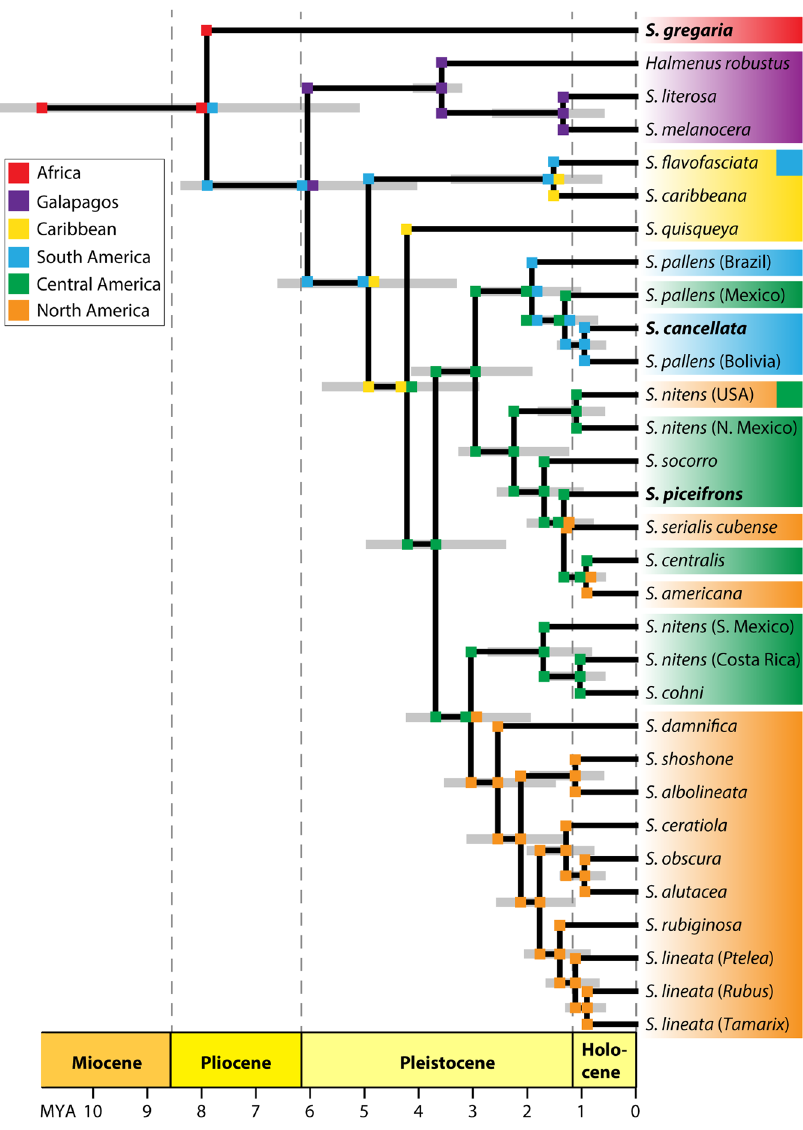
Figure 3. Time-calibrated tree of Schistocerca with estimated ancestral ranges inferred using DIVALIKE model implemented in BioGEOBEARS (d = 4.4589; e = 0.0287; LnL = − 63.73). Outgroups are not shown. The species in bold face indicate swarming locusts. Both S. flavofasciata and S. nitens (USA) have broad distribution across two defined